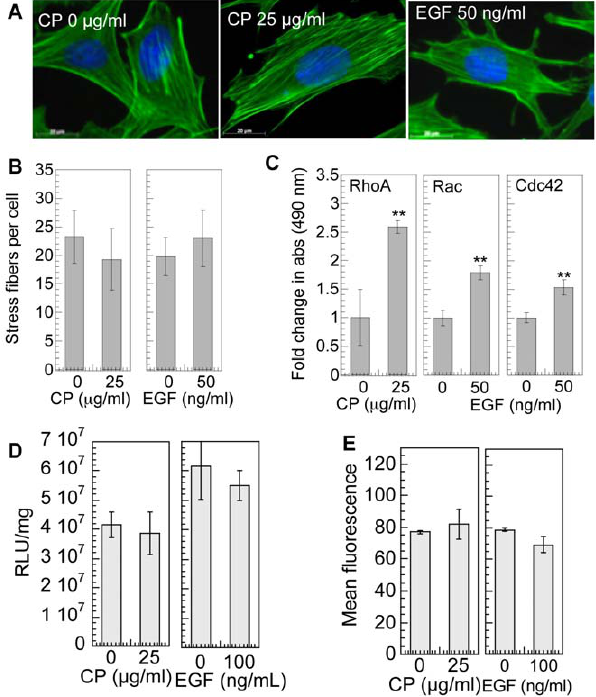
Figure 4. Effect of RhoGTPase activation using calpeptin (CP) and epidermal growth factor (EGF) on gene transfer. mMSCs cells were cultured for 8 hours on fibronectin wells, followed by overnight serum starvation and then treated with 0–100 m g/ml CP for 10 minutes or 0–100 ng/ml EGF for 2 minutes in serum free media. ( A ) After treatment, the changes in cell morphology were visualized through lexa488 conjugated phalloidin (green) and for DNA using Hoechst 33258 dye (blue) staining. Images were taken with a Zeiss AxioObserver Z1 inverted microscope at 100 6 magnification. ( B ) Stress fiber quantification. ( C ) Active RhoGTPase quantification after